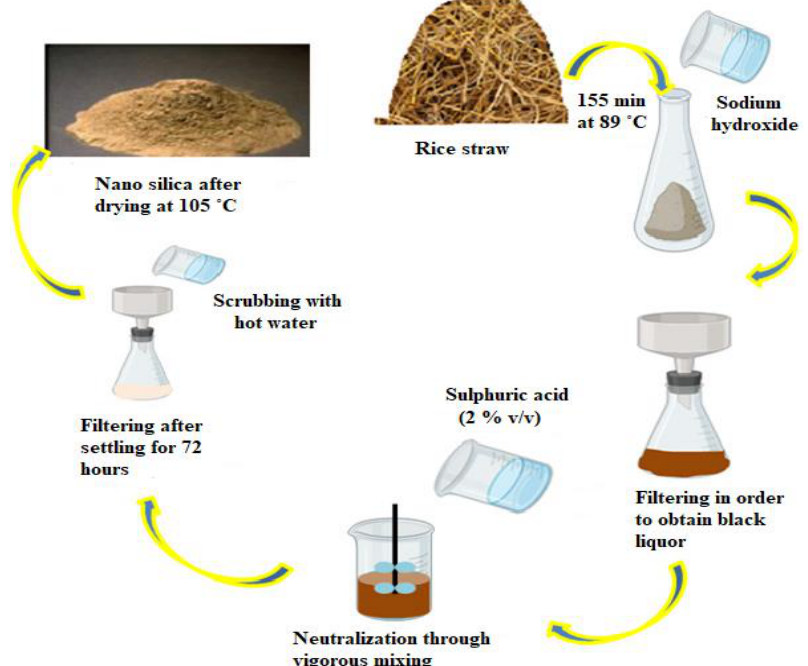
Figure 5. Different steps in the isolation of nano-silica from rice straw.